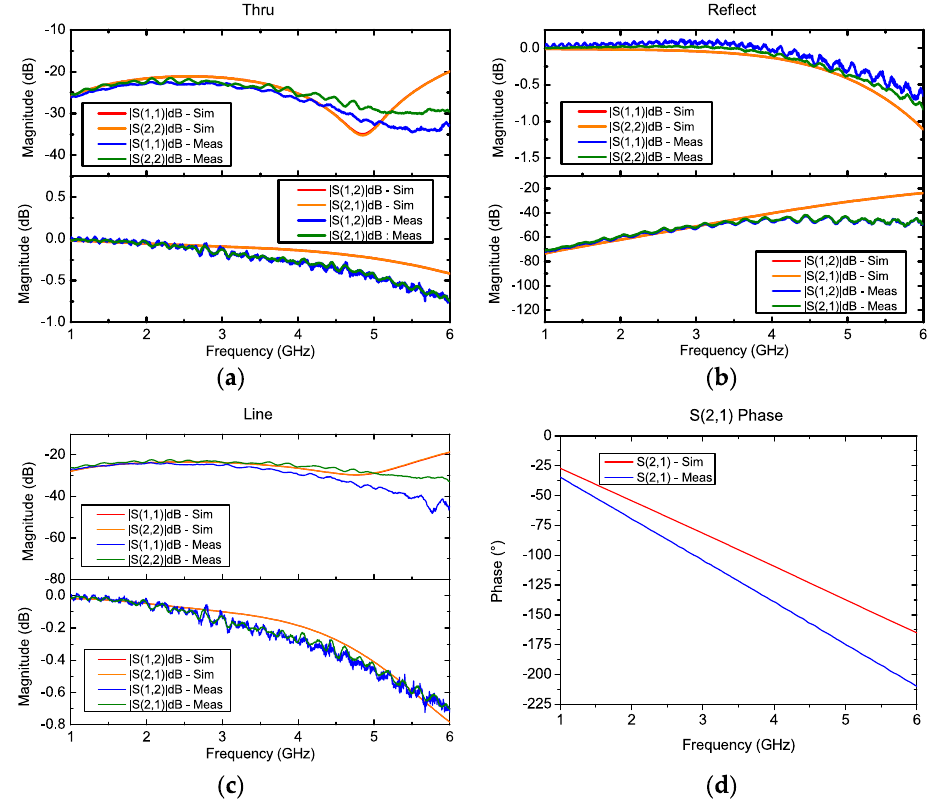
Figure 3. Comparison between simulations and measurements of the S-parameters for the three TRL standards in the frequency range from 1 GHz to 6 GHz: ( a ) Thru standard (S-parameters magnitude comparison); ( b ) Reflect standard (S-parameters magnitude comparison); ( c ) Line standard (S-parameters magnitude comparison); and ( d ) Line standard ( S 21 phase